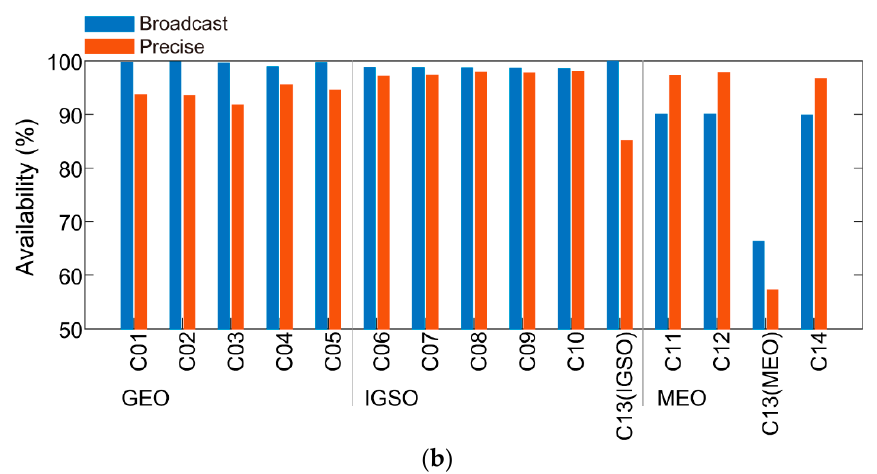
Figure 3. Availability of BDS broadcast navigation message in Multi-GNSS Experiment (MGEX)-merged navigation files and the precise product generated by Wuhan University. ( a ) Six-year series of available BDS-2 broadcast navigation message and the precise product; ( b ) Availability of BDS-2 broadcast navigation message and the precise product.